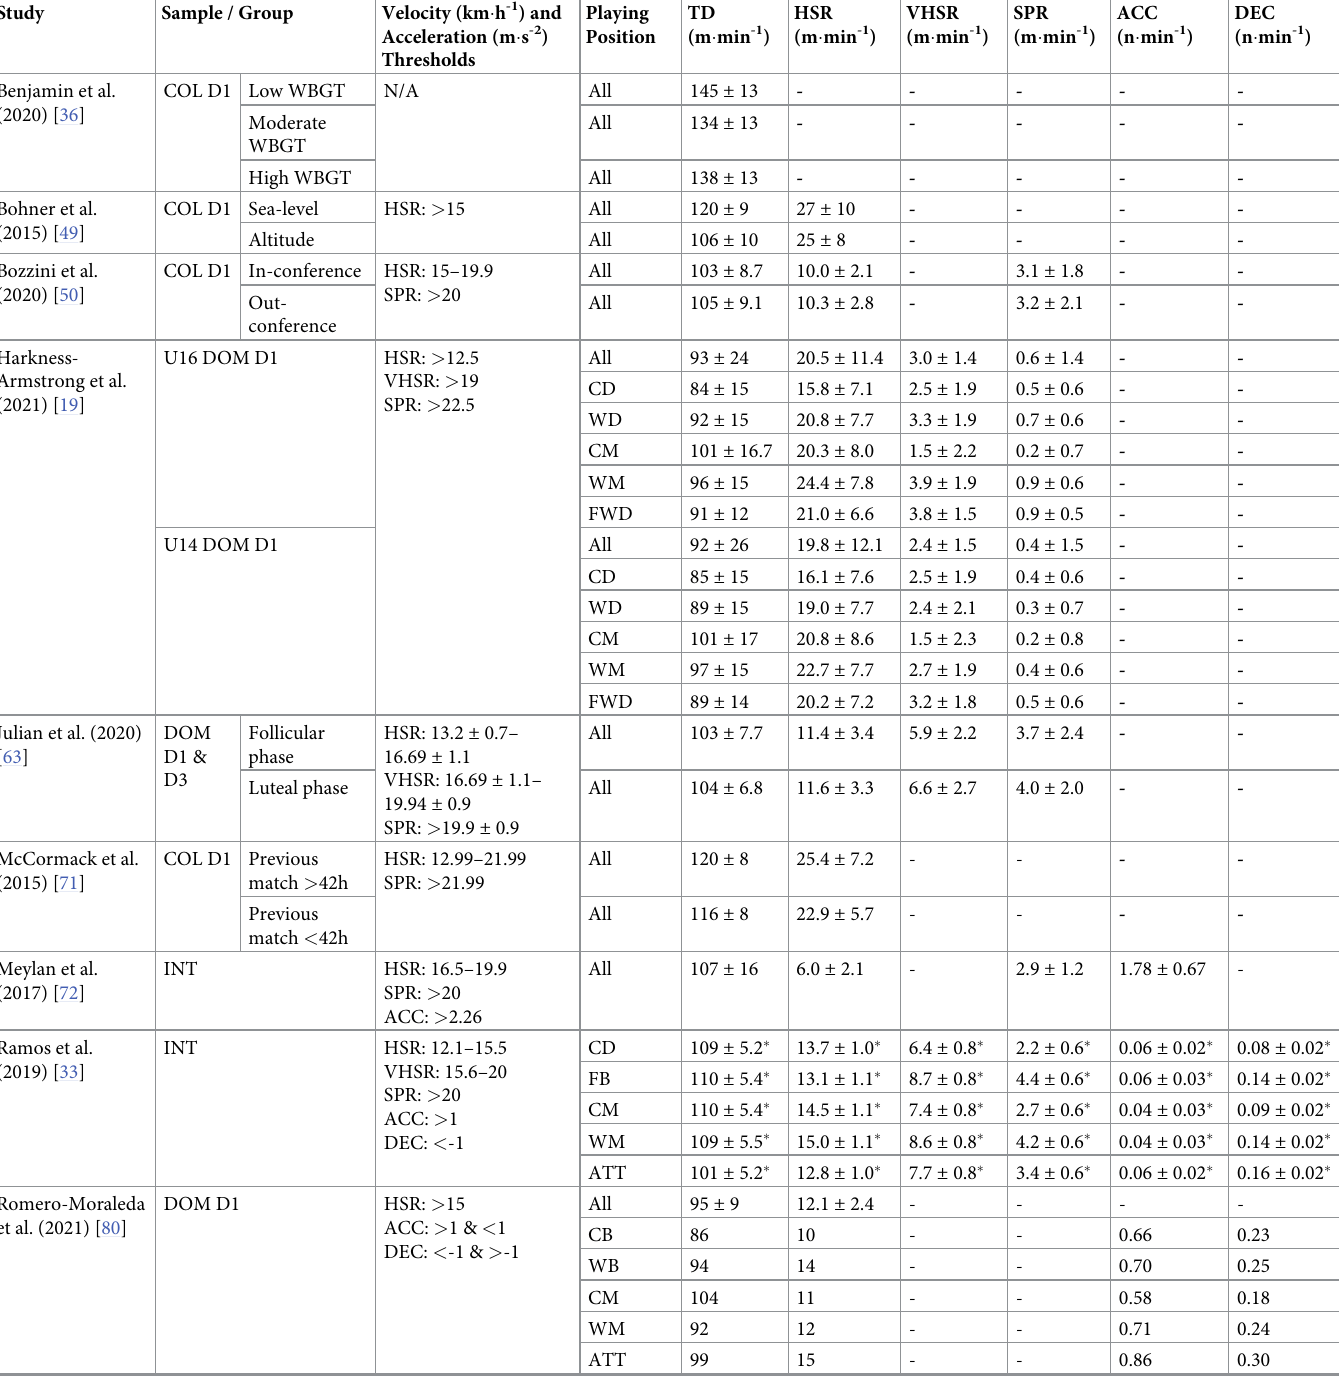
Table 7. Studies quantifying physical characteristics of women’s soccer match-play per whole-match as relative data.